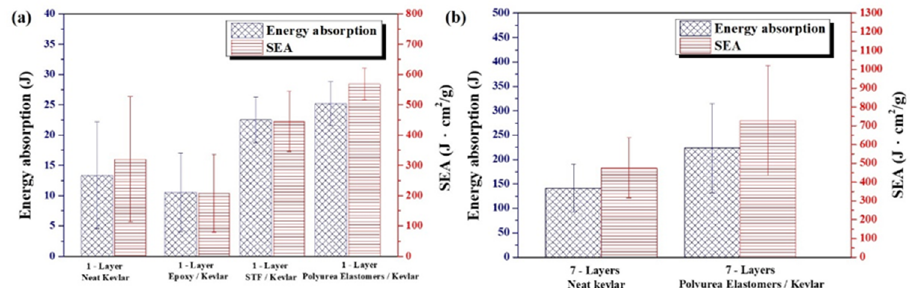
Figure 3. ( a ) Energy absorption and SEA of single-ply fabric; ( b ) Energy absorption and SEA of 7- ply fabrics. 7-ply